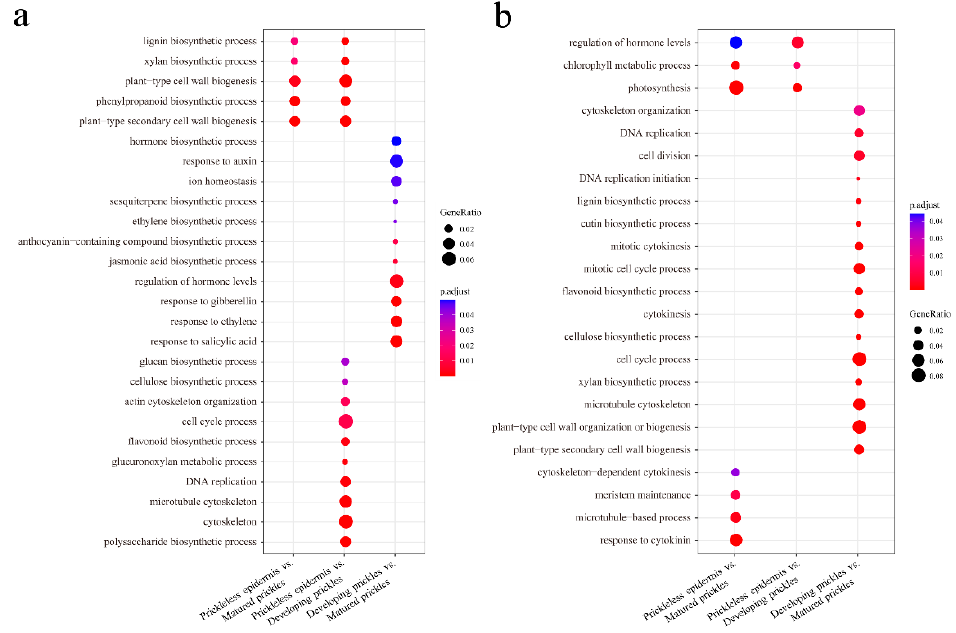
Figure 4. GO enrichment analysis of DEGs identified in the pairwise comparisons. ( a ) GO enrichment analysis of up-regulated DEGs identified in the pairwise comparisons. ( b ) GO enrichment analysis of down-regulated DEGs identified in the pairwise comparisons.